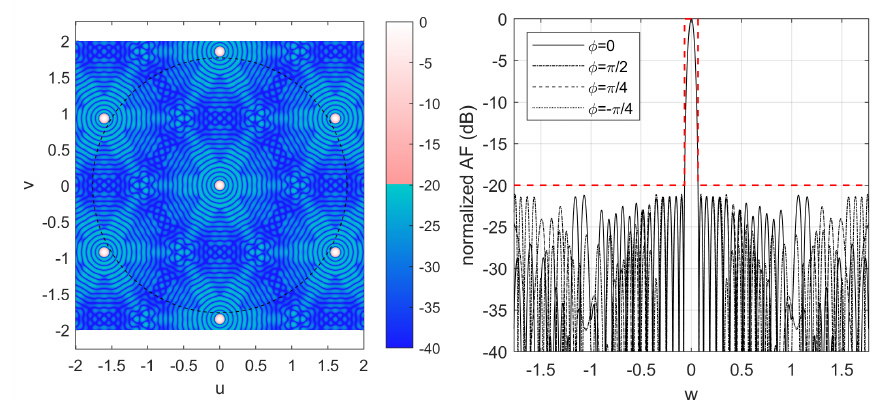
Figure 3. Triangular regular lattice array with 665 elements. Left subplot: imagemap with the power pattern of the radiated pattern. Right subplot: some relevant cuts for the normalized AF of the radiated pattern. Negative values of w are related to the cuts φ (cid:48) = φ + π